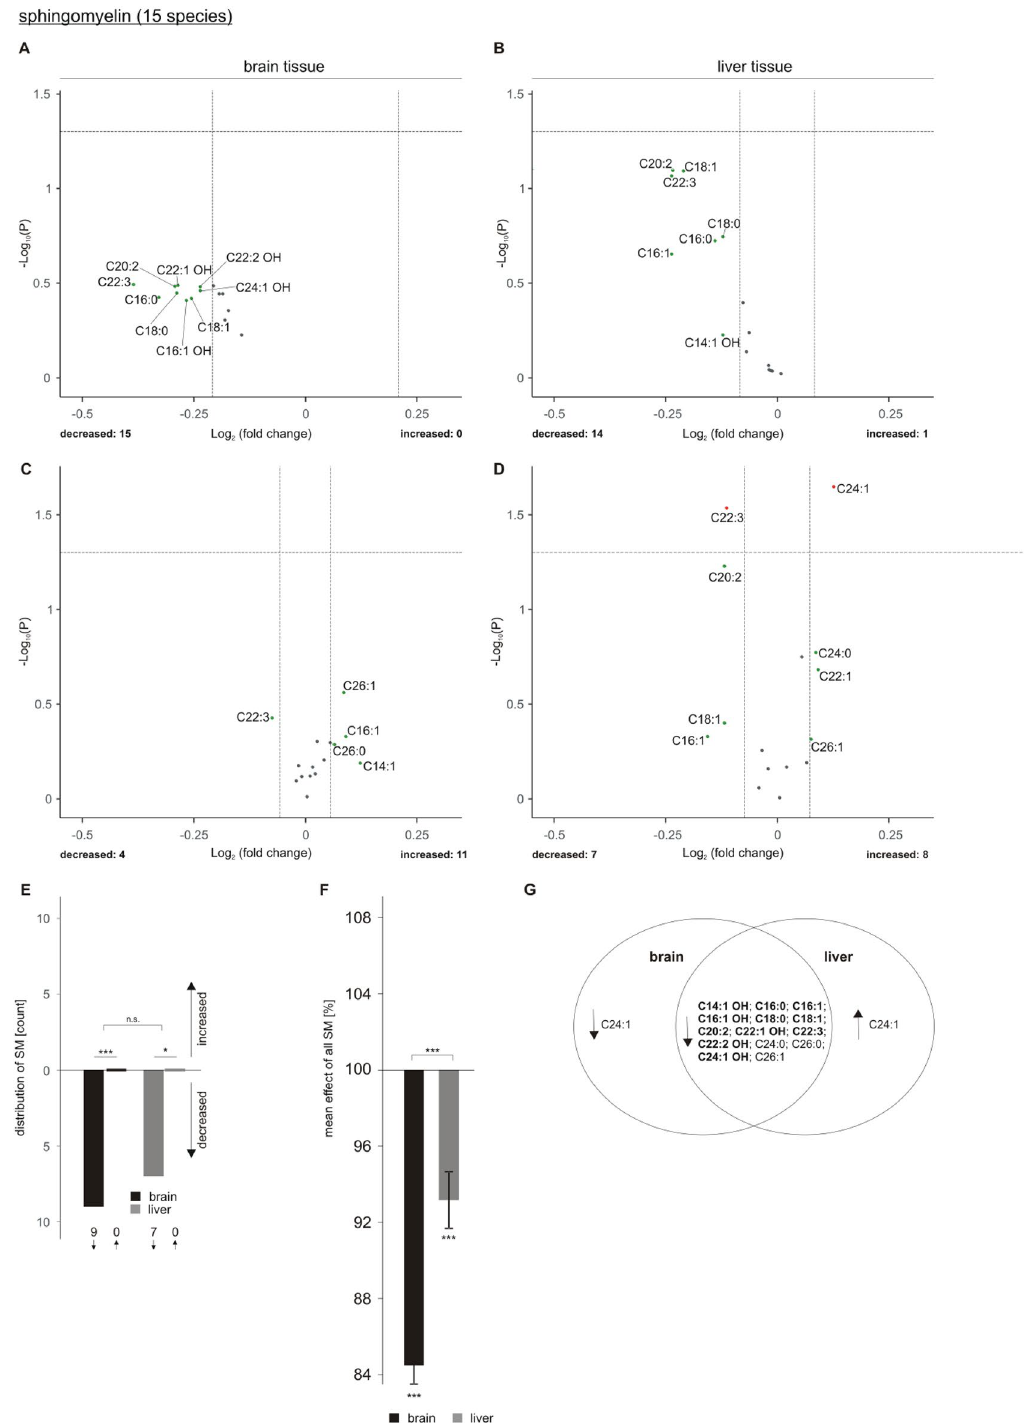
Figure 6. Changed sphingomyelin (SM) levels in 5xFAD brain and liver tissue after acitretin treatment. Fold changes of single SM species in brain and liver tissue are shown as volcano plots at the top ( A : brain tissue, B : liver tissue) and the effects of single species independent of lipid class effect for the analyzed species are presented as appropriate volcano plot at the bottom ( C : brain tissue, D : liver tissue). Structure and labeling of the volcano plots are according to Fig. 2. ( E ) Distribution of SM species represented as number of de- and increased parameters in brain and liver tissue in a bar chart. ( F ) Mean effects on all SM in brain and liver tissue are shown in a bar chart. Statistical significance for ( E ) and ( F ) was calculated according to Fig. 3. ( G ) Venn diagram showing exclusively changed as well as overlapping SM species in brain and liver tissue. Species with a fold change greater than the SEM are highlighted in